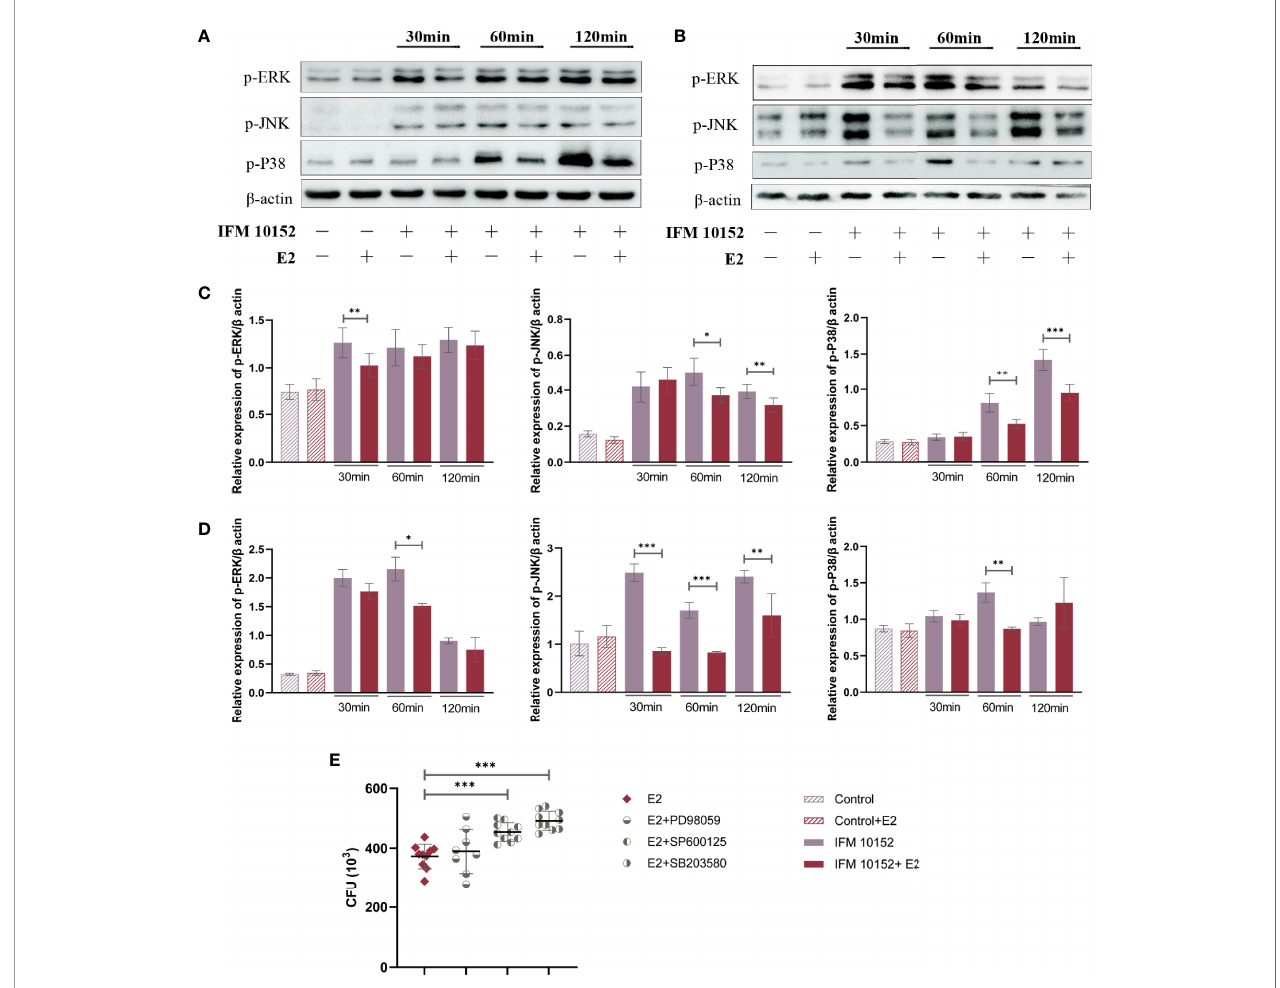
FIGURE 5 | E2 promotes bacterial survival by downregulating the MAPK signaling pathway. A549 (A) and RAW 264.7 (B) cells were treated with or without 50 nM E2 for 16 – 18 h prior to Nocardia infection. Western blot analysis of the phosphorylation levels of ERK (p-ERK), JNK (p-JNK), and p38 (p-p38) after 30, 60, and 120 minutes of infection. The relative expression of each protein in A549 (C) and RAW 264.7 (D) cells was analyzed by Image J. (E) Bacterial survival in RAW 264.7 cells treated with 20 m M PD 98059, 20 m M SP 600125, or 20 m M SB 203580. Lines display means with SEM. Data are from 3 independent experiments. * P < 0.05, ** P < 0.01, and *** P <